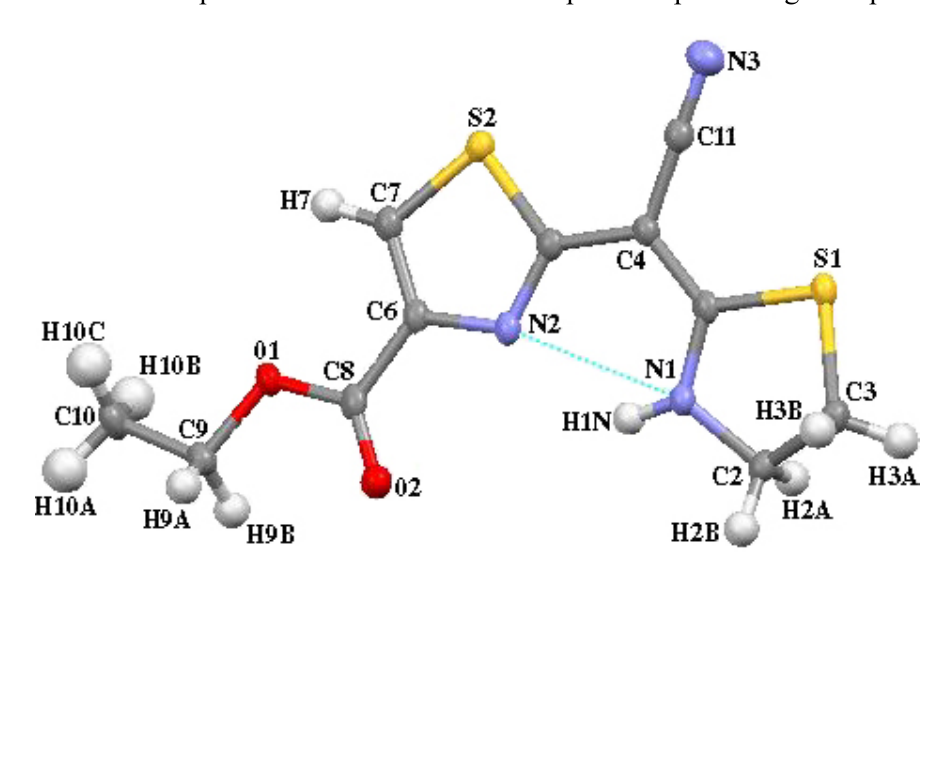
Figure 1. Molecular plot of 5a with the thermal ellipsoids representing 50%